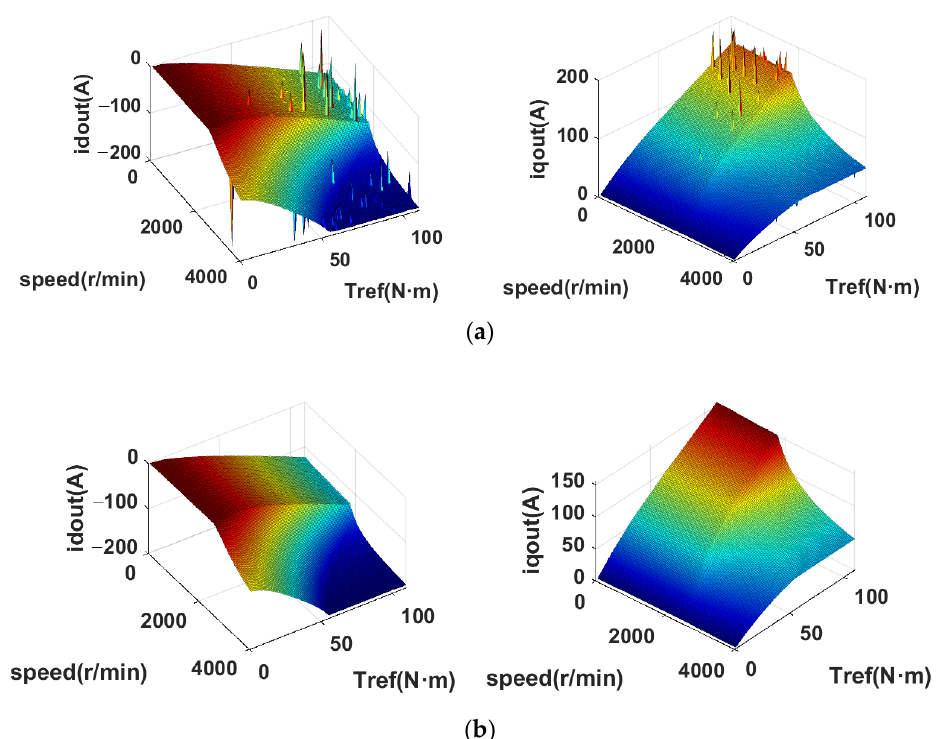
Figure 18. Optimization results based on the improved NMS search method: ( a ) basic NMS method; ( b ) anti-degenerate NMS method.